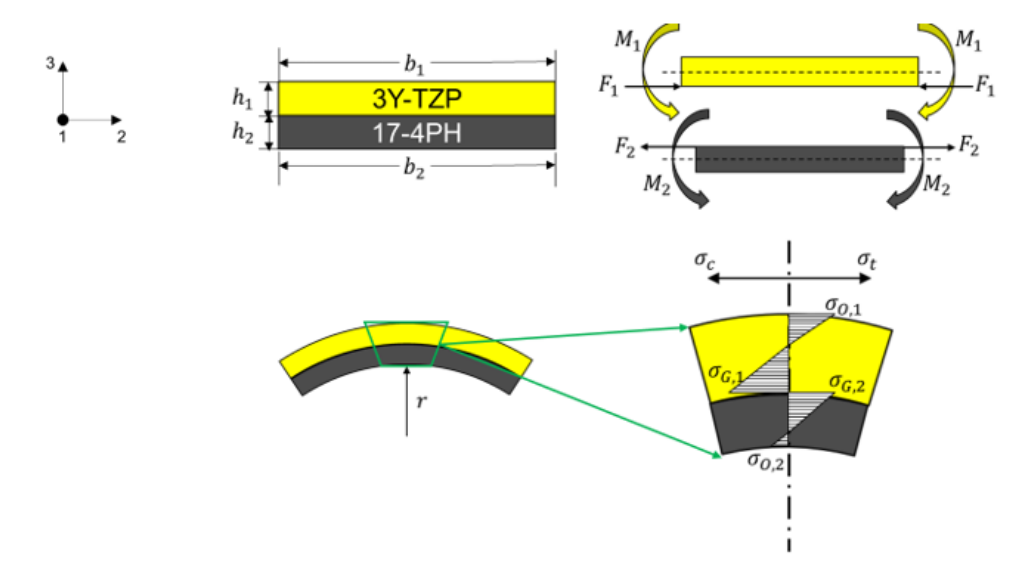
Figure 5. Schematic drawing of the curvature and stress distribution of a two-layer laminate and its coordinate system.